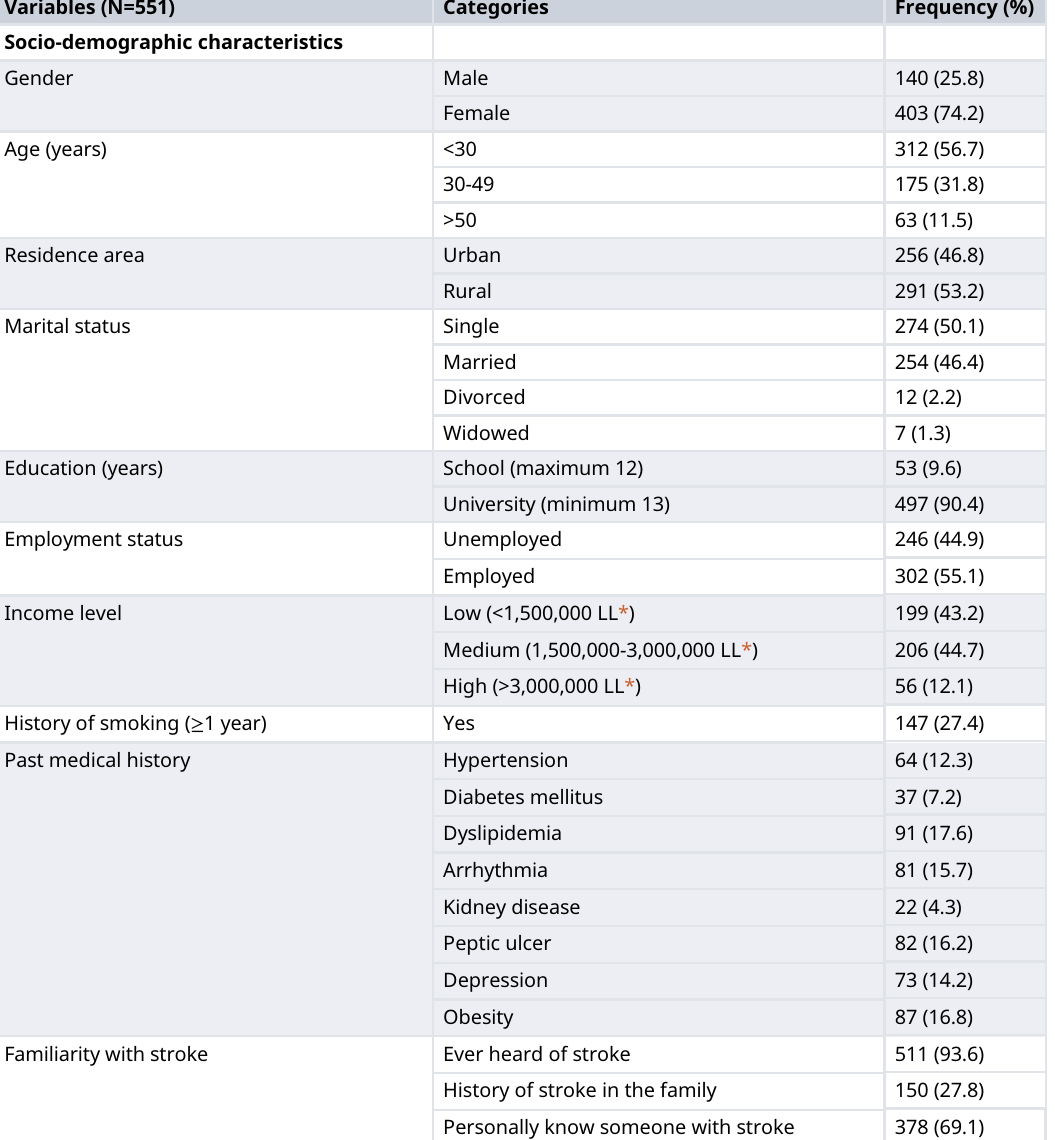
Table 1. Participants ’ socio-demographic characteristics, past medical history, and familiarity with